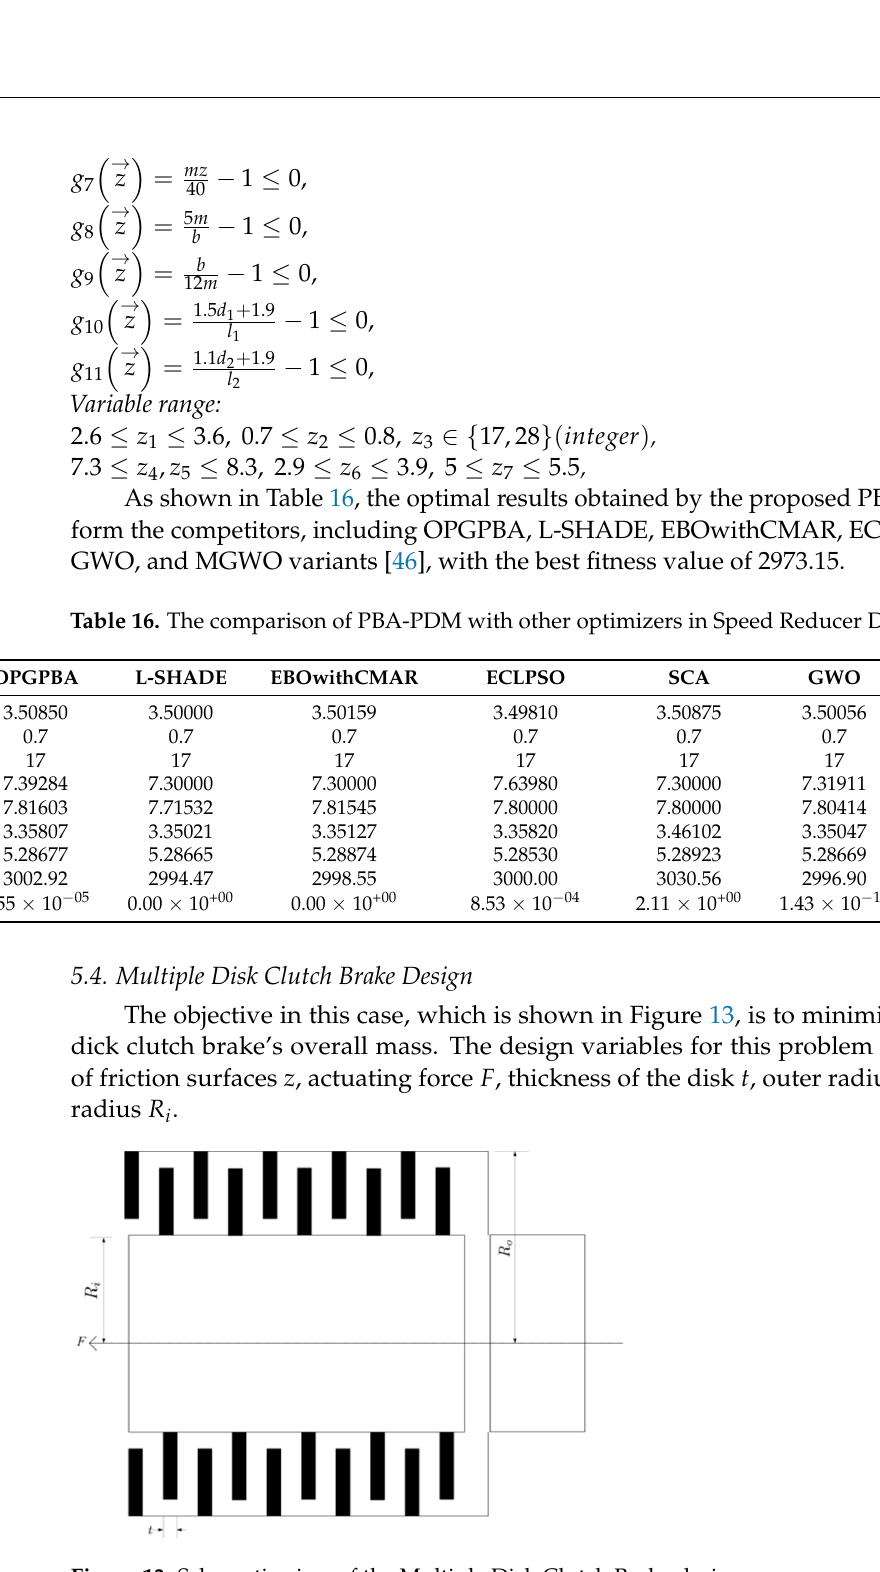
Figure 13. Schematic view of the Multiple Disk Clutch Brake design.